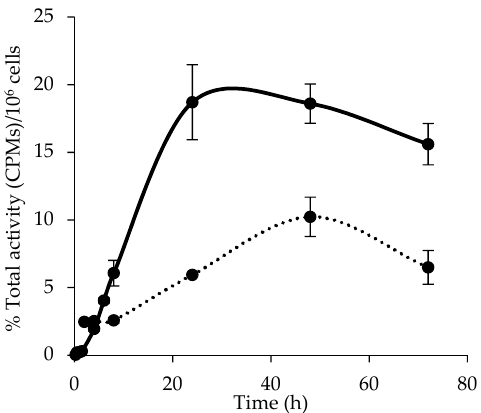
Figure 3. Uptake kinetic carried out with [ 64 Cu]Cu-NOTA-C3-TP on the HCT116 cells (solid line) and GM05757 normal fibroblast cells (dotted line). Data are presented as the percentage of total activity (%)/10 6 cells.